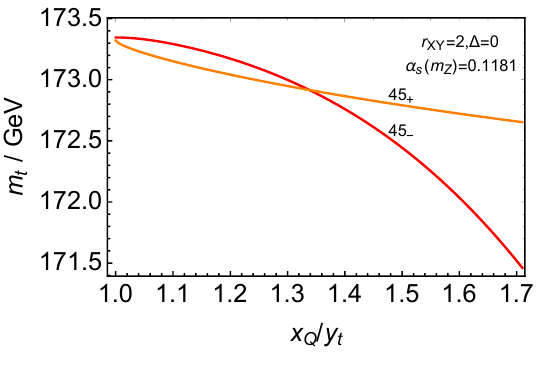
Figure 8 . The dependence of the predicted top quark mass m t on x Q in the 3221